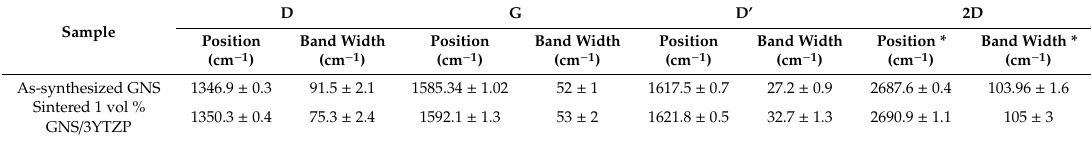
Table 2. Positions and band widths of the D, G, D’ and 2D bands obtained for the as-synthesized GNS and the GNS in the sintered composite after fitting the first- and second-order Raman spectra. Sample